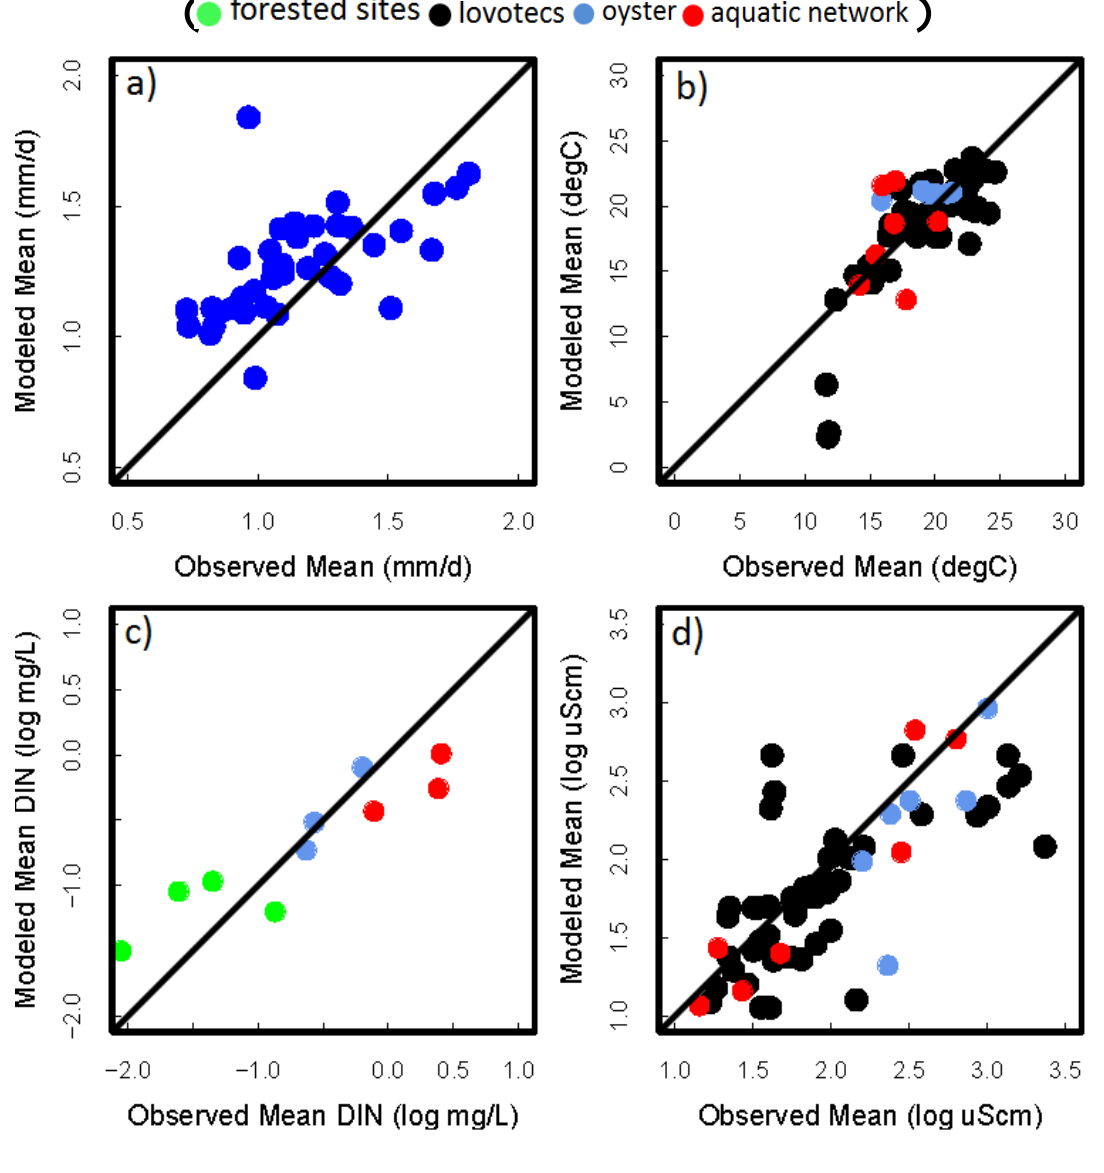
Fig. A4.2. Comparison of mean daily (summer only) modeled values with observations for a) streamflow (mm/d), b) water temperature (degC), c) DIN (mg/L) and d) specific conductivity